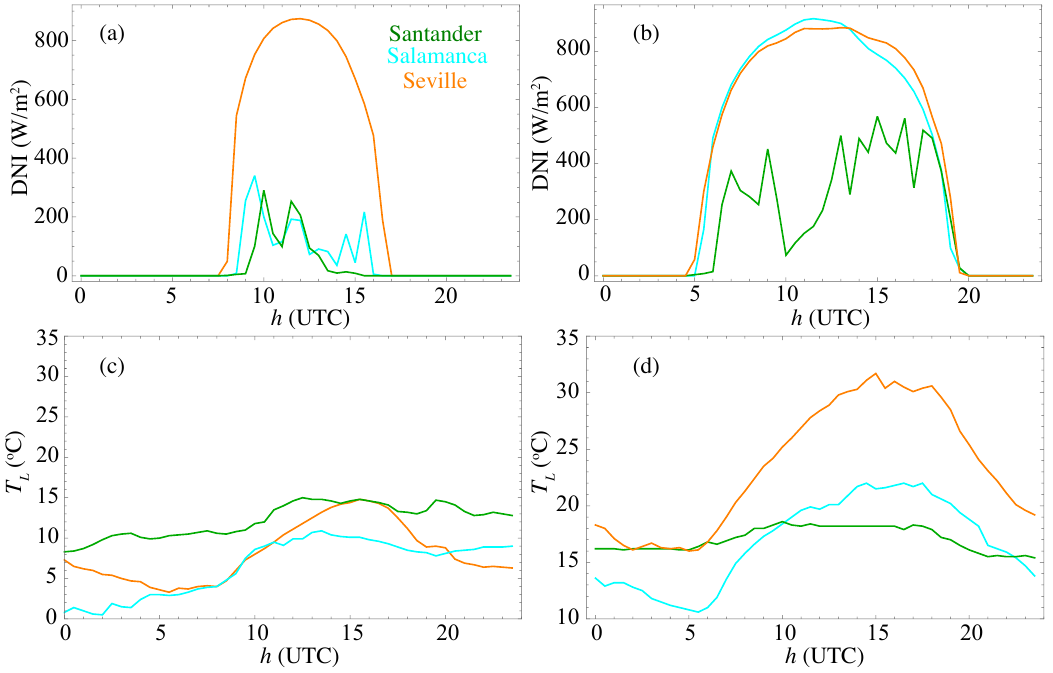
Figure 4. Samples of the DNI and ambient temperature, T L , for the considered locations on particular days in winter and summer: ( a , c ) corresponds to 13 December 2017 and ( b , d ) to 13 June 2018. DNI data were obtained from Copernicus Atmosphere Monitoring Service (CAMS) [45] and temperatures from AEMET